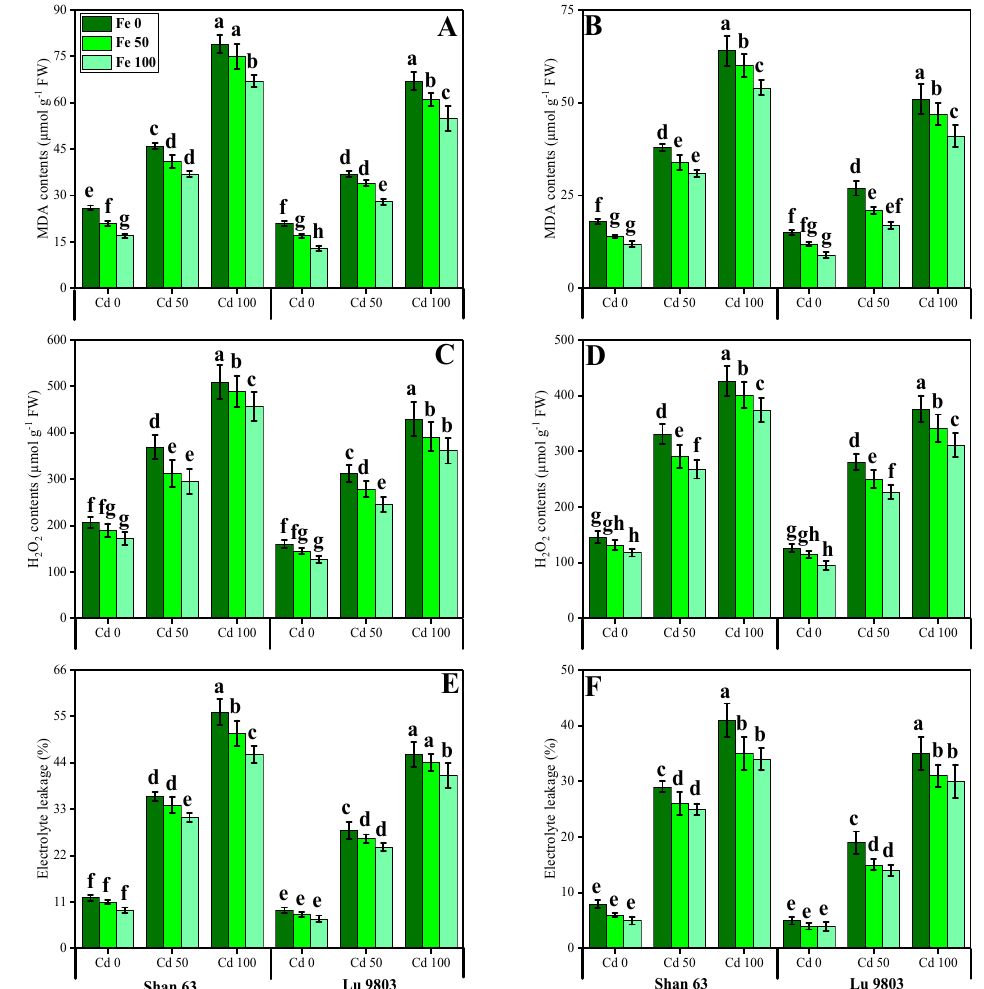
Figure 3. Effect of different concentrations of exogenous application of FeSO 4 (0, 50, and 100 µM) on oxidative stress indicators, i.e., MDA contents in the roots ( A ), MDA contents in the leaves ( B ), H 2 O 2 contents in the roots ( C ), H 2 O 2 contents in the leaves ( D ), EL percentage in the roots ( E ) and EL percentage in the leaves ( F ) of Oryza sativa (cultivars) grown under different levels of Cd stress (0, 50 and 100 µM). Bars sharing different letter(s) for each parameter are significantly different from each other according to Duncan’s multiple range test ( p < 0.05). All the data represented are the average of four replications ( n = 4). Error bars represent the standard deviation (SD) of four